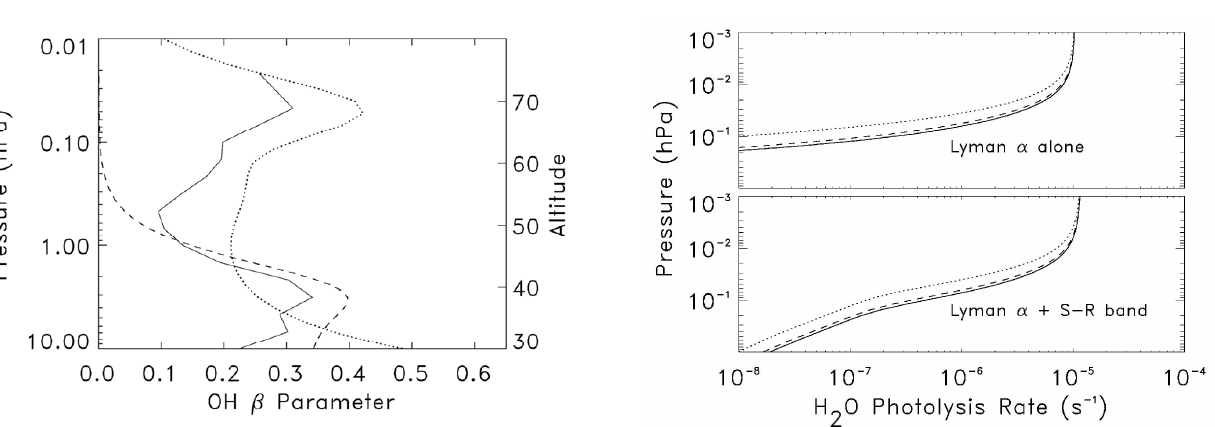
Fig. 6. Photodissociation rates for water vapor for Lyman α wave- lengths (top) and for Lyman α plus the S-R band spectral region Figure 6: Photodissociation rates for water vapor for Lyman a wavelengths (top) and (bottom). In both plots, the solid, dashed, and dotted curves corre- spond to SZA values of 0 ◦ , 30 ◦ and 60 ◦ , respectively. for Lyman a plus the S-R band spectral region (bottom). In both plots, the solid, dashed, and dotted curves correspond to SZA values of 0 o , 30 o and 60 o , respectively.